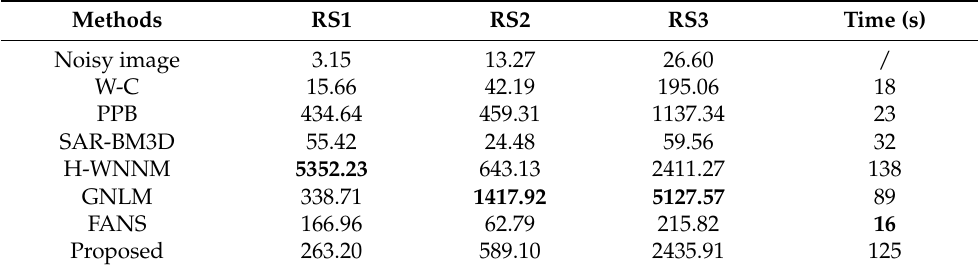
Table 4. The ENL and run times (in seconds) of all filters on real-world SAR images.